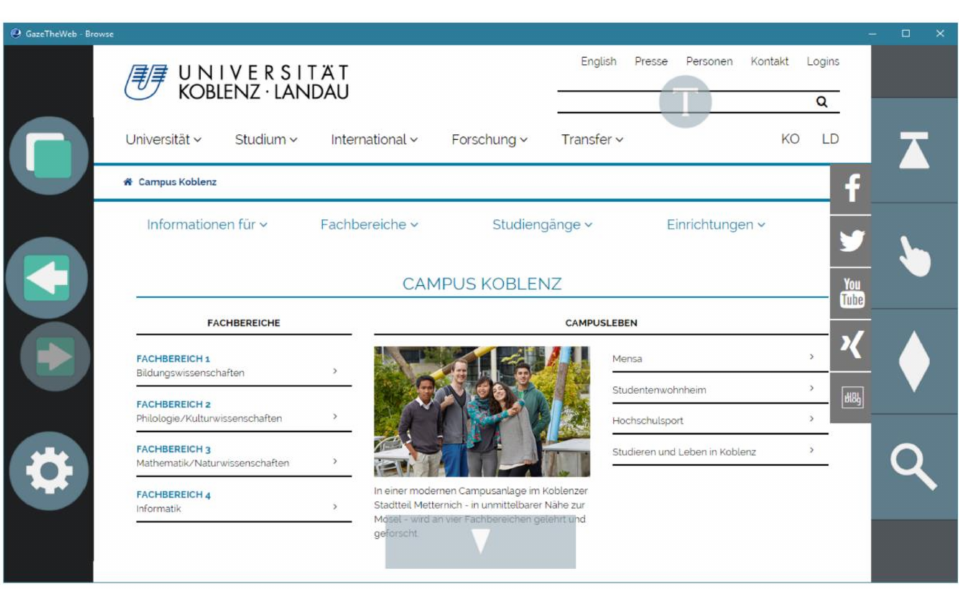
Figure 1. An eye-controlled browser based on eyeGUI